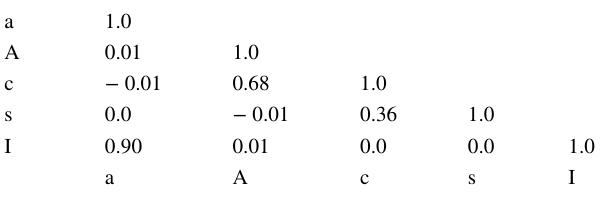
the outputs of the classifier. Solid lines represent forward operations, while dashed ones represent gradient propagation. At each step m , gradients from the prediction loss and the adversary loss are summed to form the target for the next decision tree h m + 1 Table 1 Correlation matrix of the synthetic